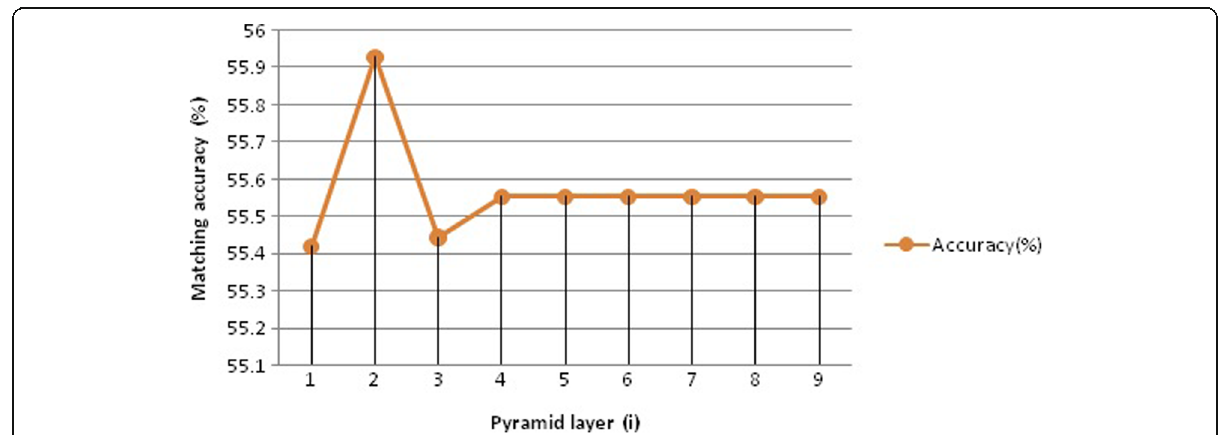
Fig. 9 Diagram of the number of pyramid layers and matching